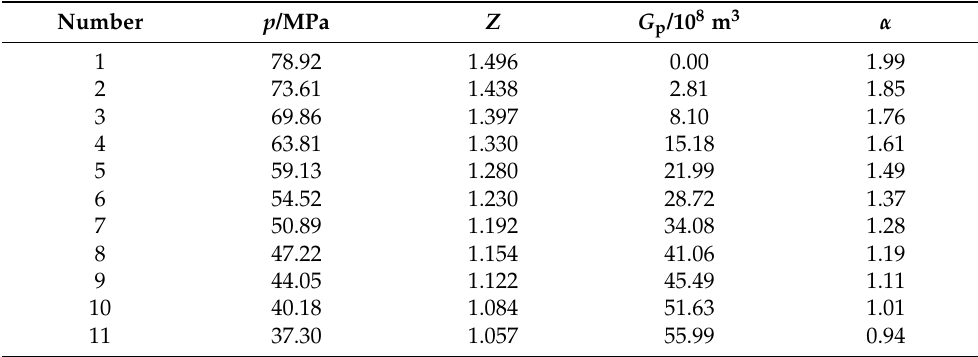
Table A2. Historical production data of the Louis. Offshore reservoir